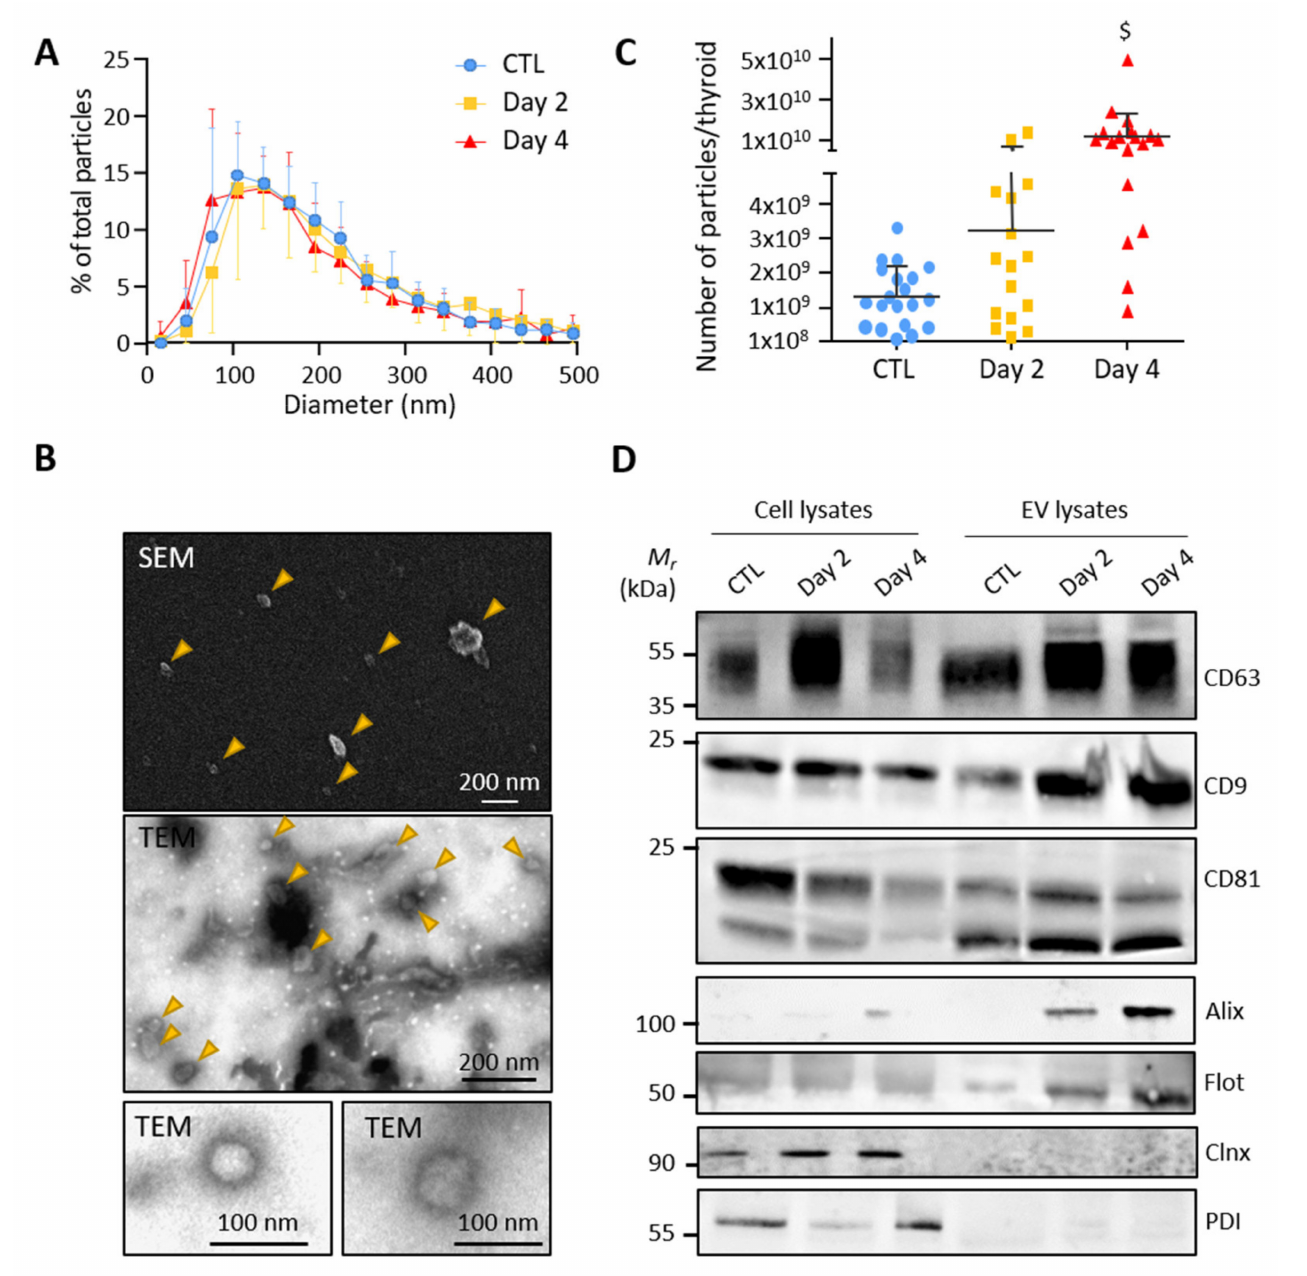
Figure 2. Small EVs isolated from control and BRAF V600E thyroid tissues display exosomal char- acteristics: ( A ) nanoparticle tracking analysis (NTA) of resuspended EV-pellets from control and doxycycline-treated thyroids after 2 and 4 days of injections. Results are presented as the percentage of total particles as a function of particle diameter; ( B ) scanning and transmission electron microscopy of resuspended EV-pellets isolated from dissociated control thyroid. The SEM and the first TEM images show large overview of the sample; arrowheads point EV structures; ( C ) NTA quantification of particle numbers from the EV-pellets. $ stands for p < 0.001; ( D ) biochemical characterization of EV lysates as compared to cell lysates by the western blotting of five EV-markers (CD63, CD9, CD81, Alix and Flottilin-1) and two reticulum endoplasmic markers (Calnexin and Protein